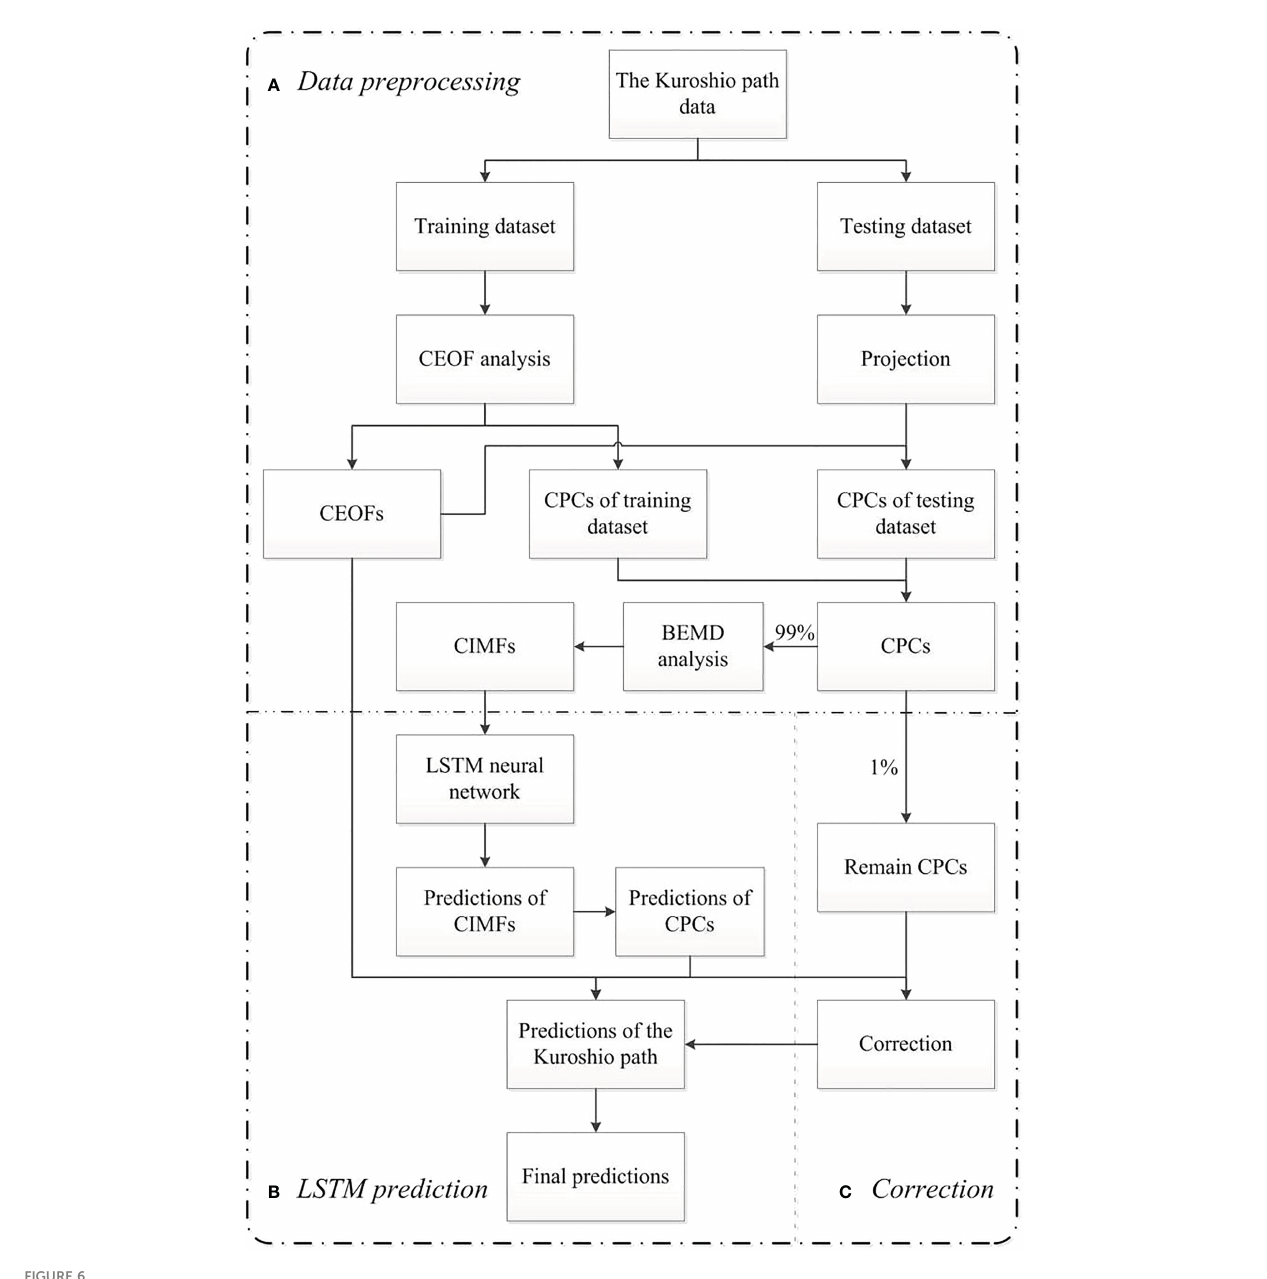
FIGURE 6 Framework of CEOF-BEMD-LSTM